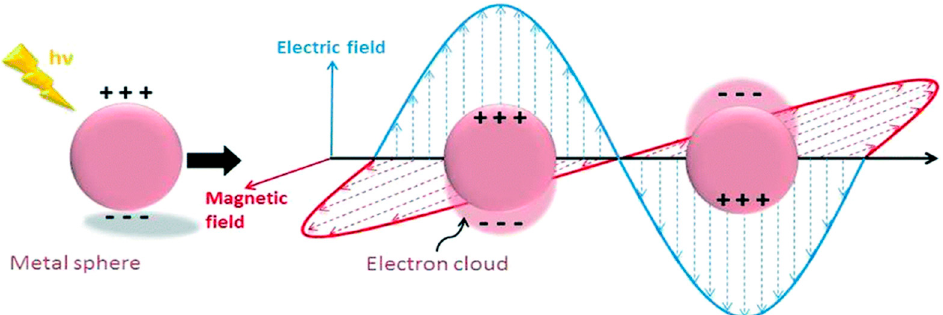
Figure 2. Schematic diagram of the free oscillating electrons at the nanosphere interface due to the electric field applied with arbitrary polarizations. Reprinted with reference [12].